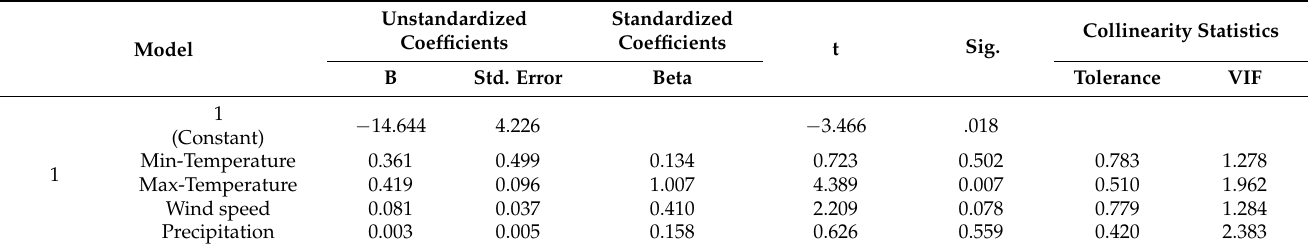
Table 1. Coefficients † of multicollinearity of climatic factors with two groups of J . seravschanica .